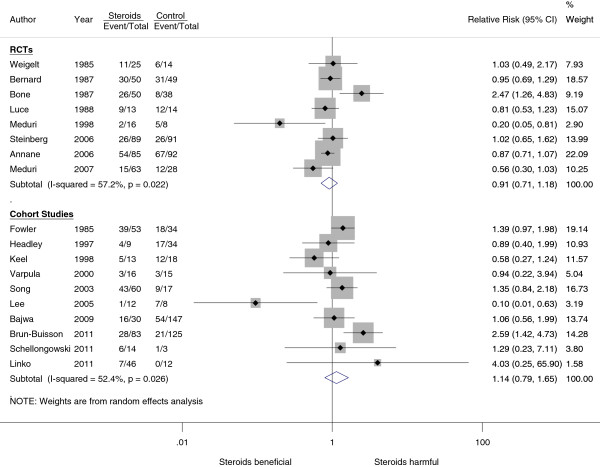
Effect of corticosteroids on hospital or 60-day mortality.